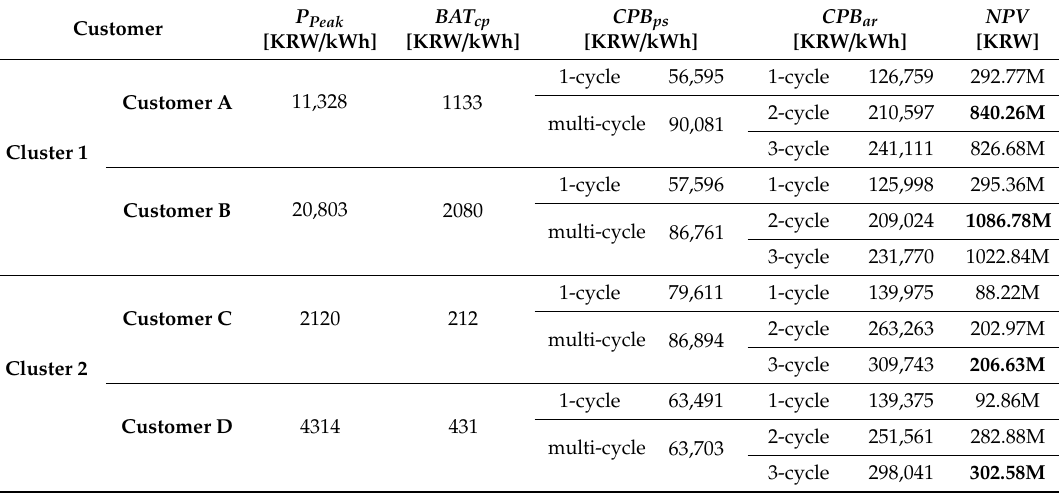
Table 8. Feasibility analysis results of the customer-installed